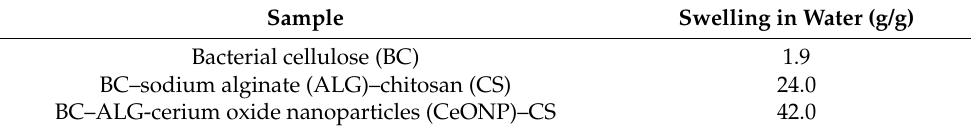
Table 1. Equilibrium swelling of bacterial cellulose (BC), BC–ALG–CS, and BC–ALG(CeONP)–CS films.